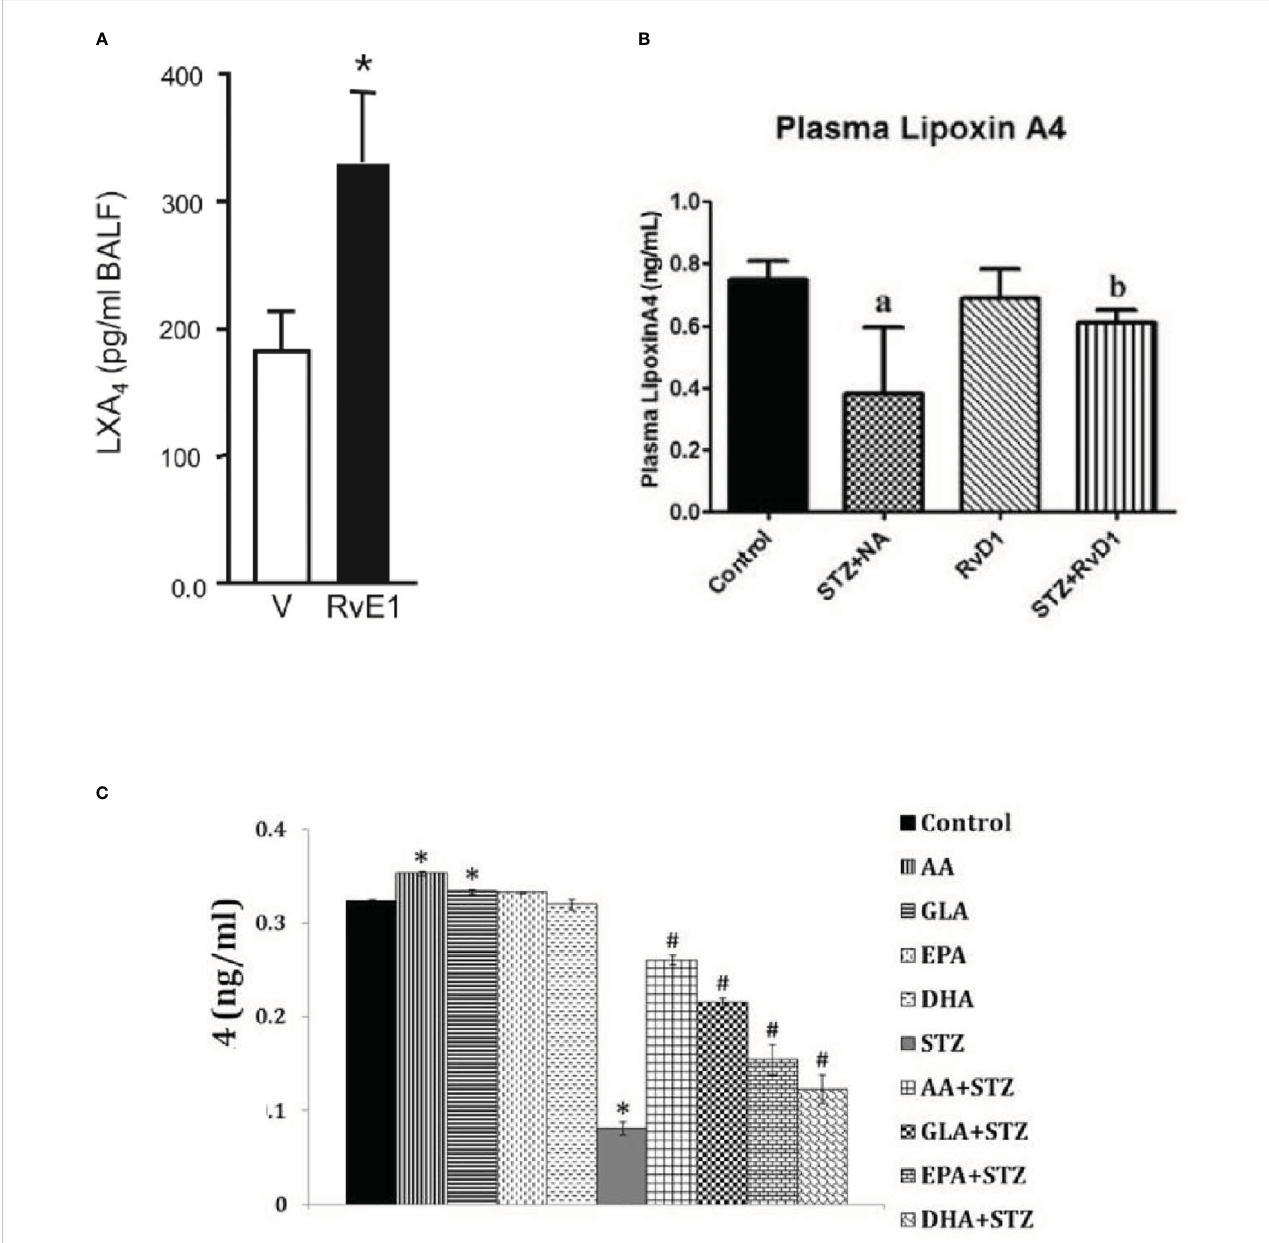
FIGURE 5 (A) Effect of resolvinE1 (derived from EPA) on lxa4 formation in bronchial alveolar fl uid f animals with allergic airway in fl ammation that received 50/100 ng/day of resolvin E1 (this data is takn from reference 50. *P<0.05 compared to vehicle control. (B) Effect of resolvin D1 (derived from DHA) give intraperitoneally (60 ng/animal) to STZ induced type 2 DM animals on plasma LXA levels. a P < 0.001 compared to untreated control; b P<0.01 compared to STZ+NA (streptozotocin + nicotinamide) treated group. This data is taken from reference 37. (C) Effect of various unsaturated fatty acids on the generation of LXA4 inhibited by streptozotocin-treated RIN (rat insulinoma) cells in vitro . It is evident that STZ suppressed LXA4 generation by RIN cells that is restored to near normal by AA, while other fatty acids especially EPA and DHA also induced LXA4 generation to a signi fi cant degree compared to STZ treated cells but are much less potent compared to AA. RIN cells were treated with STZ (21 mM) and fatty acid concentration used was 10 m g/ml. *P < 0.05 compared to control; # P < 0.05 compared to